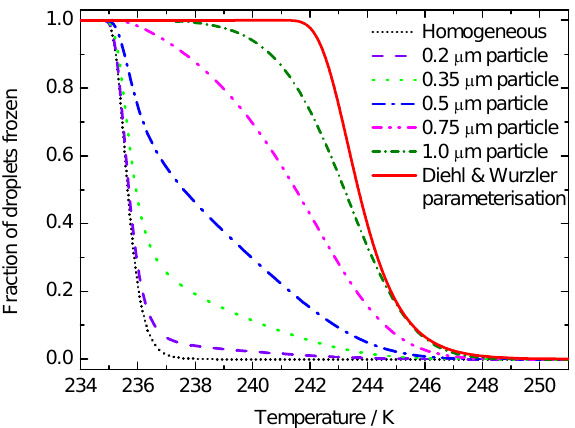
Fig. 17. Fraction of droplets frozen as a function of temperature for droplets containing an internal mixture of 0.01 wt% NX illite and 0.15wt% kaolinite. The blue line is our predicted f ice (T ) curve based on Eq. (22) and using the parameterisations for ice nucle- ation by kaolinite (Murray et al., 2011b) and NX illite (Eq. 19). The predicted f ice (T ) curves assuming only illite and only kaoli- nite were present are also shown. The experimental f ice (T ) curve was produced using 34 droplets in the 10–20µm size range. The surface area of clay available in the median volume droplet ( V = 1 . 1 × 10 − 9 cm 3 ) was s =1 . 39 × 10 − 7 cm 2 , 1 . 92 × 10 − 7 cm 2 for il- lite and kaolinite, respectively; the cooling rate was 10.0Kmin − 1